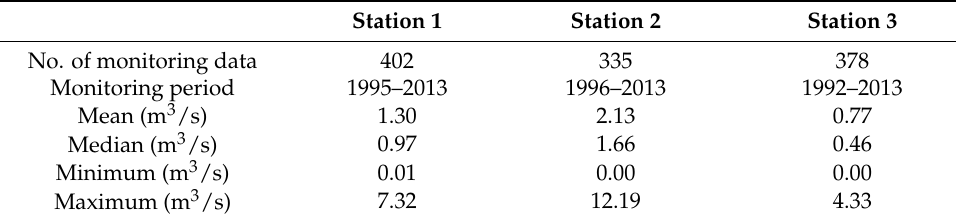
Table 1. Summary of the drainage flow rate data for the three monitoring stations at the